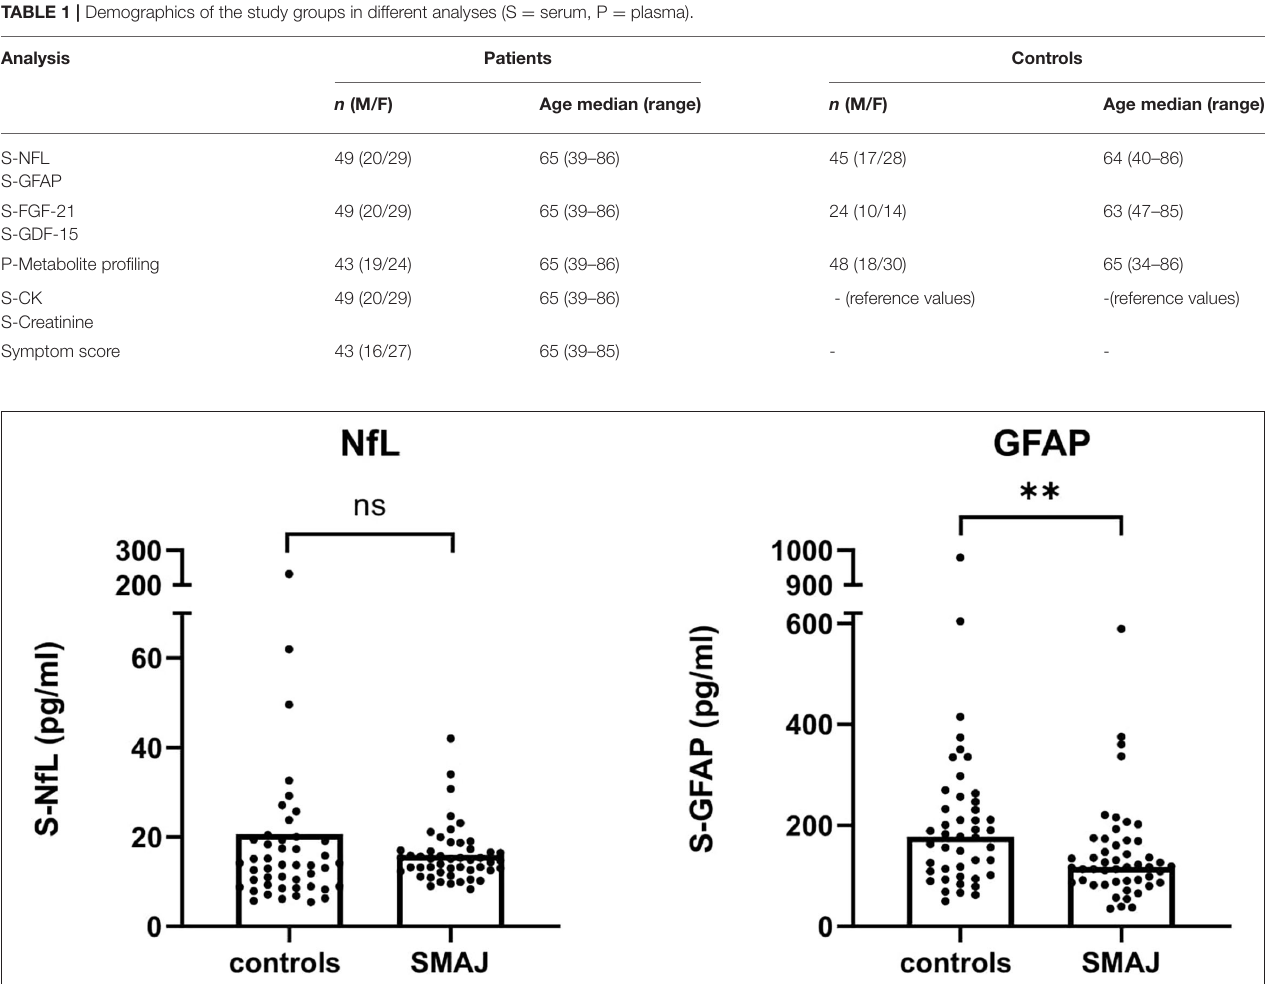
FIGURE 1 | Serum neurofilament light is not elevated in SMAJ. Comparison of serum concentrations of NfL and GFAP between patients with SMAJ ( n = 49) and controls ( n = 45). The median per group is indicated by a bar. ** p < 0.01, Mann–Whitney U